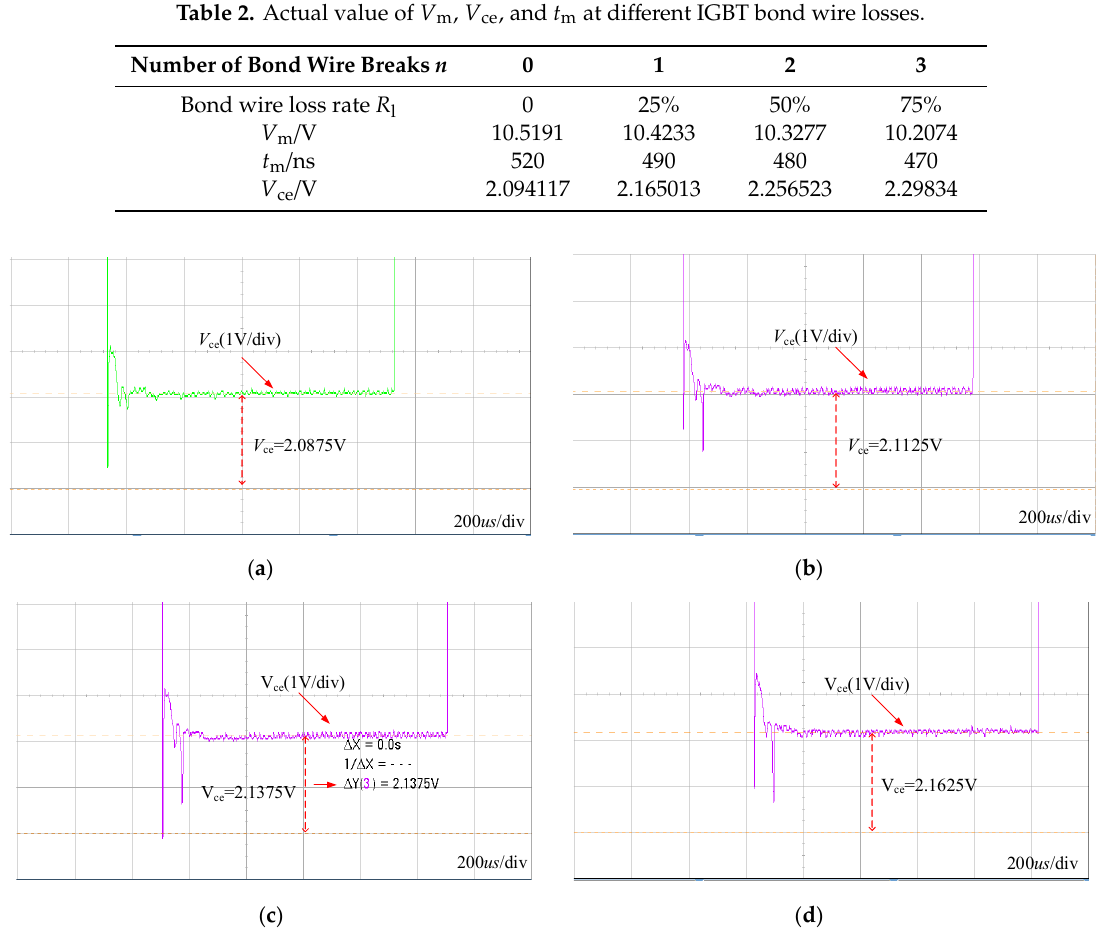
Figure 10. Waveform of V ce at different IGBT bond wire losses: ( a ) bond wire without loss; ( b ) bond wire after one break; ( c ) bond wire after two breaks; ( d ) bond wire after three breaks.